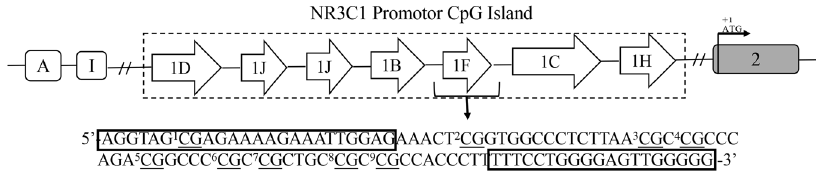
Fig. 1 Analysed region of NR3C1 1 F promoter. The region from nucleotide − 3184 to − 3082 (numbers relative to the translation start site considered as + 1) of the 5 ′ - end of NR3C1 gene. Underlined: analysed CpG sites; square boxes: position of primers for ampli fi cation of bisul fi te-treated